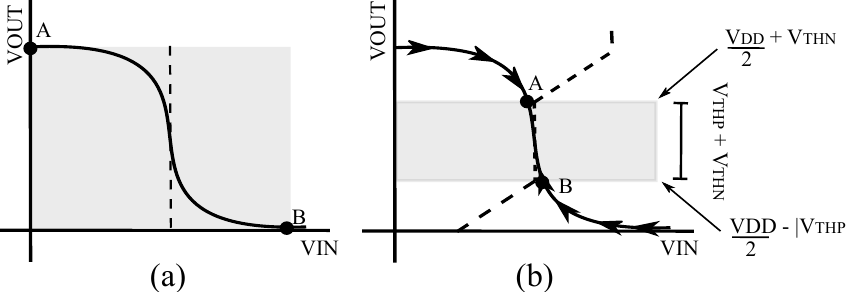
Figure 4. Static analysis of two possible scenarios. ( a ) PFGA characteristic curves for a voltage buffer always turned off ( b ) PFGA characteristic curves for a voltage buffer with limited OFF region. The OFF buffer region is represented with a grey colored